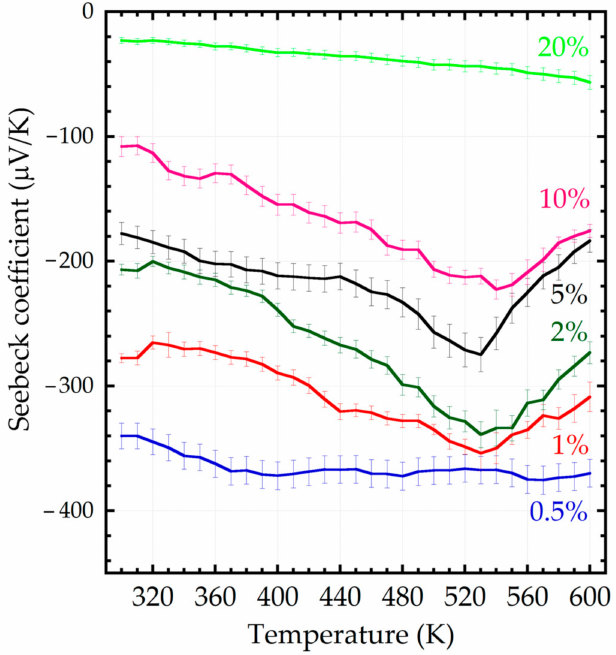
Figure 5. Seebeck coefficient values as a function of the